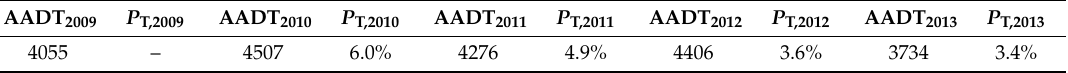
Table 2. Traffic flow rates in 2013, traffic count station ID 904020.